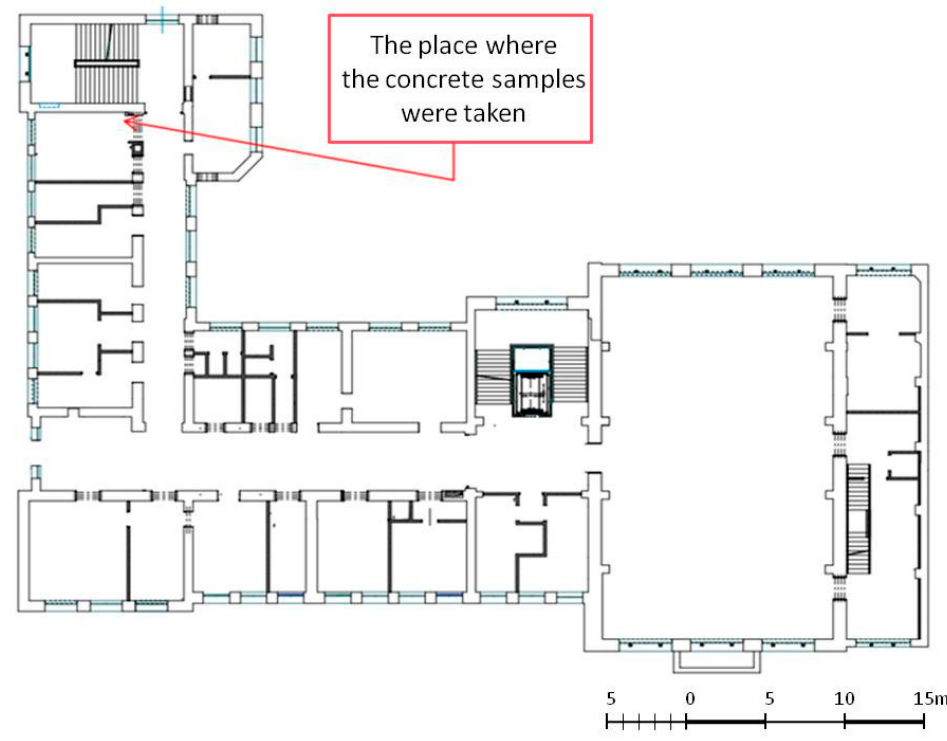
Figure 10. The locations in the building from which the concrete samples were taken for testing.